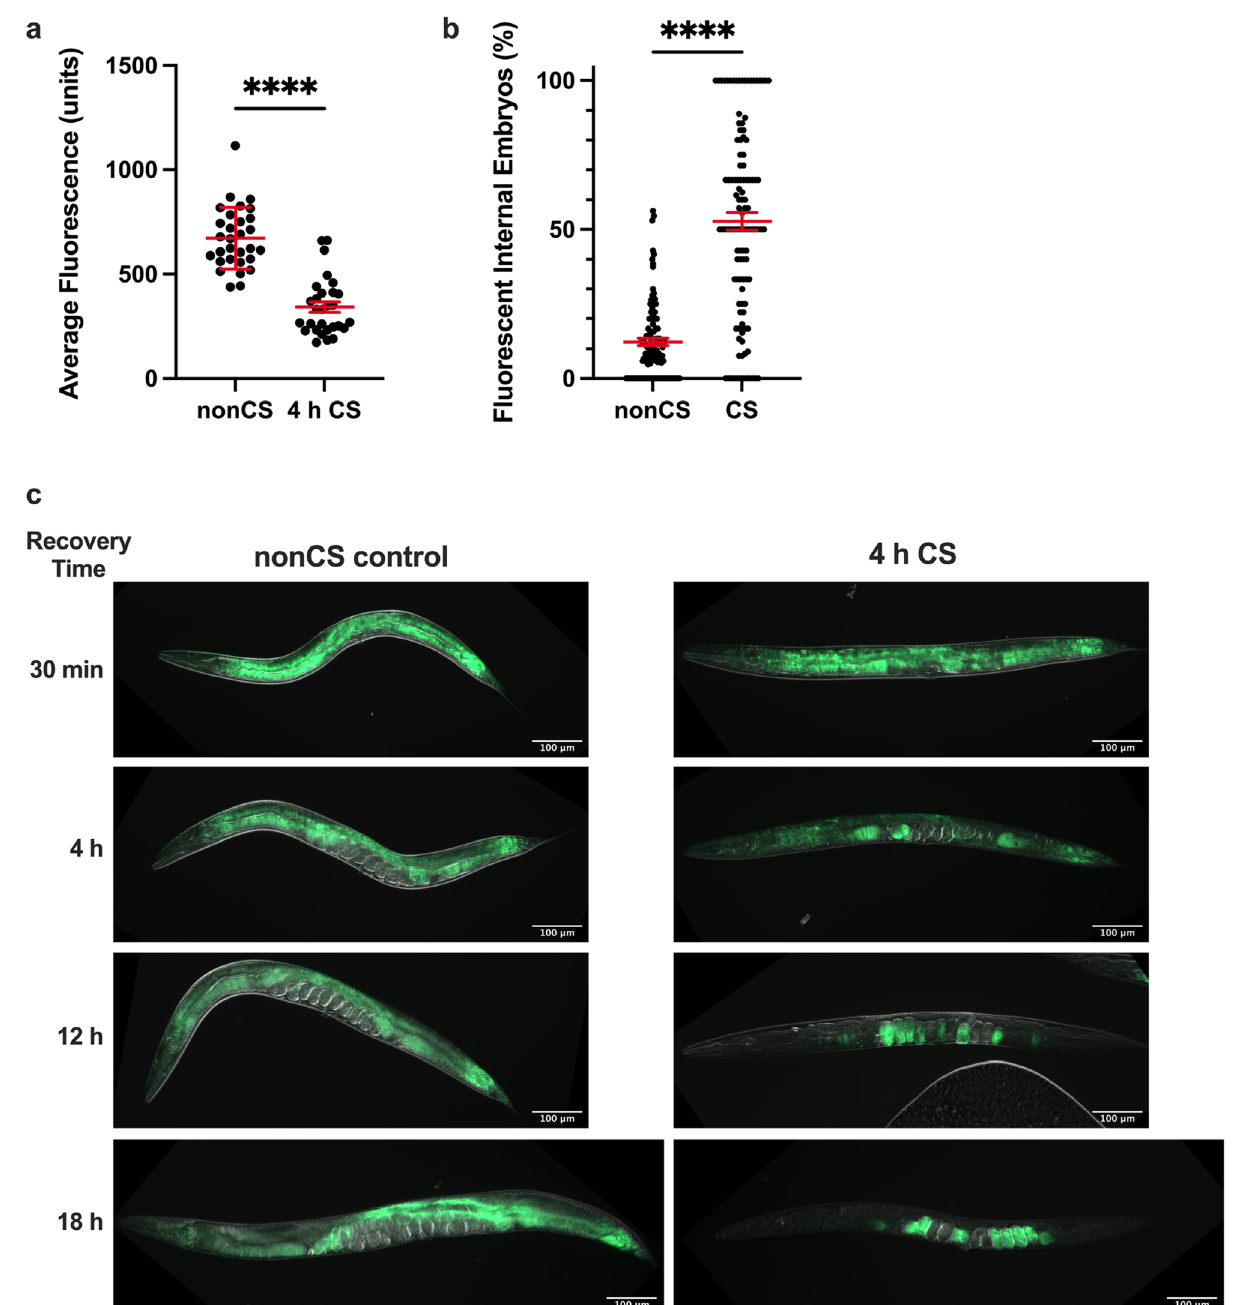
Figure 2. Cold shock recovery is associated with lipid localization shifts from the intestine to the germline. Young adult N2 hermaphrodites were exposed to 2 °C cold shock or control nonCS conditions (20 °C) for 4 h and recovered before Nile Red staining and imaging for lipid content. ( a ) Average fluorescence per worm (n ≥ 29 per condition; Mann–Whitney U test: U = 48; two-tailed P < 0.0001) and ( b ) percent of internal fluorescent embryos per worm (n ≥ 111; Mann–Whitney U test: U = 1885; two-tailed P < 0.0001) were quantified 12 h post-CS. Error bars are mean ± s.e.m. ( c ) Representative images of Nile Red-stained worms at indicated time points post-CS show progression of intestinal lipid loss and relocalization to the impact on fertility independent of this thermosensation pathway. Taken together, though, these data support the hypothesis that fat reallocation as a stress response following CS may depend on a neuronal mechanism for induction. Since TAX-2/TAX-4 plays a role in temperature sensation, we speculate that canonical cold ther- mosensation is required for lipid reallocation to take place.